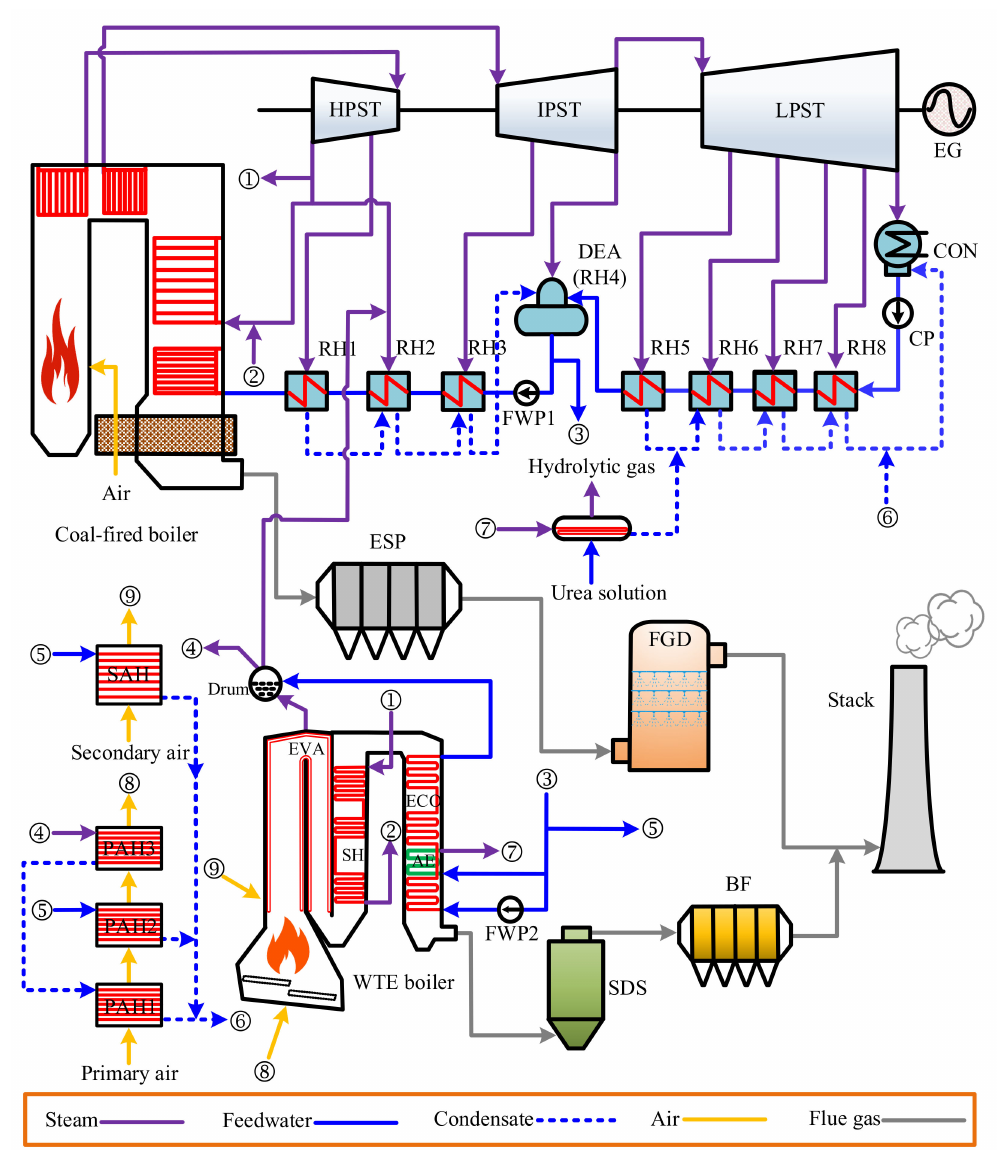
Figure 3. Diagram of the proposed integration